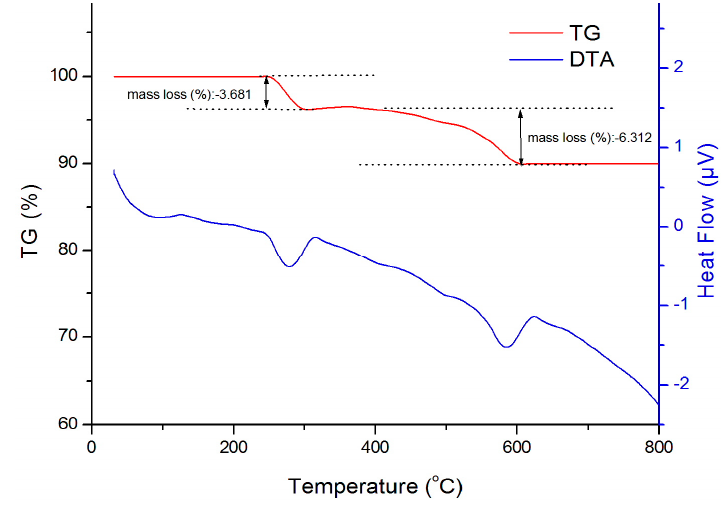
Figure 3. Thermal analysis diagram of the sample obtained in 10 min.